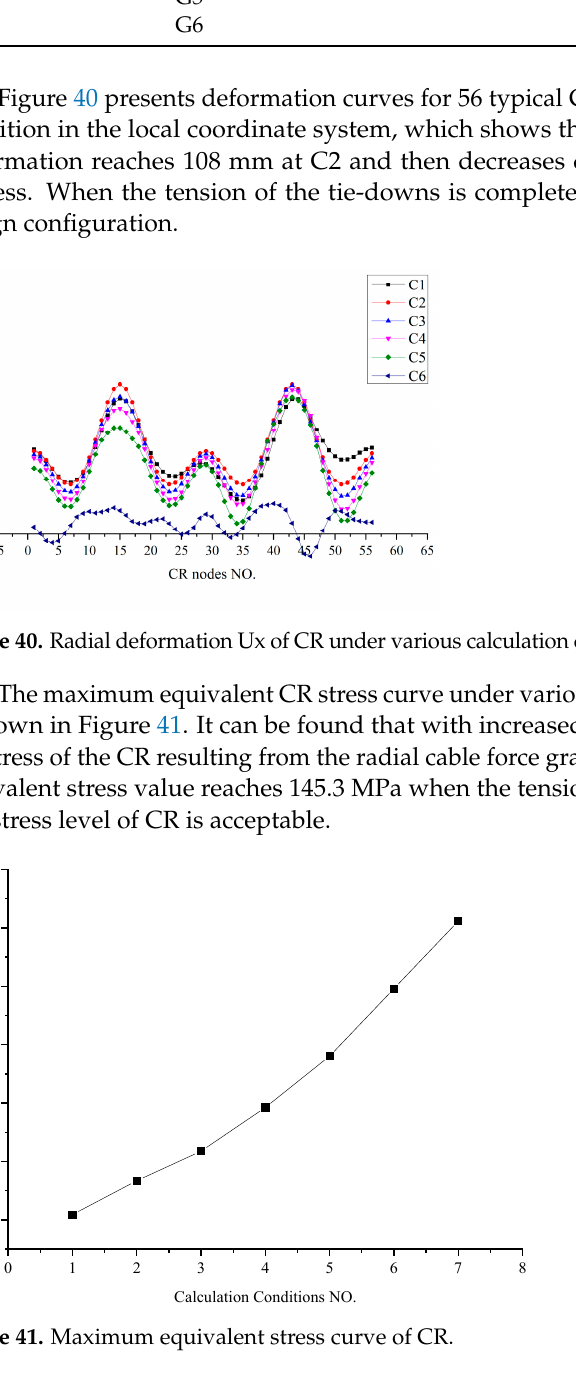
Figure 41. Maximum equivalent stress curve of CR. Tie-down force nephograms in Figure 42 show the distribution of tie-down forces during the tension process. All tie-down forces increase during the whole tension process. The maximum tension force is 547.6 kN, and the cable force of tie-downs at the long and short axes is significantly greater than at 45°.